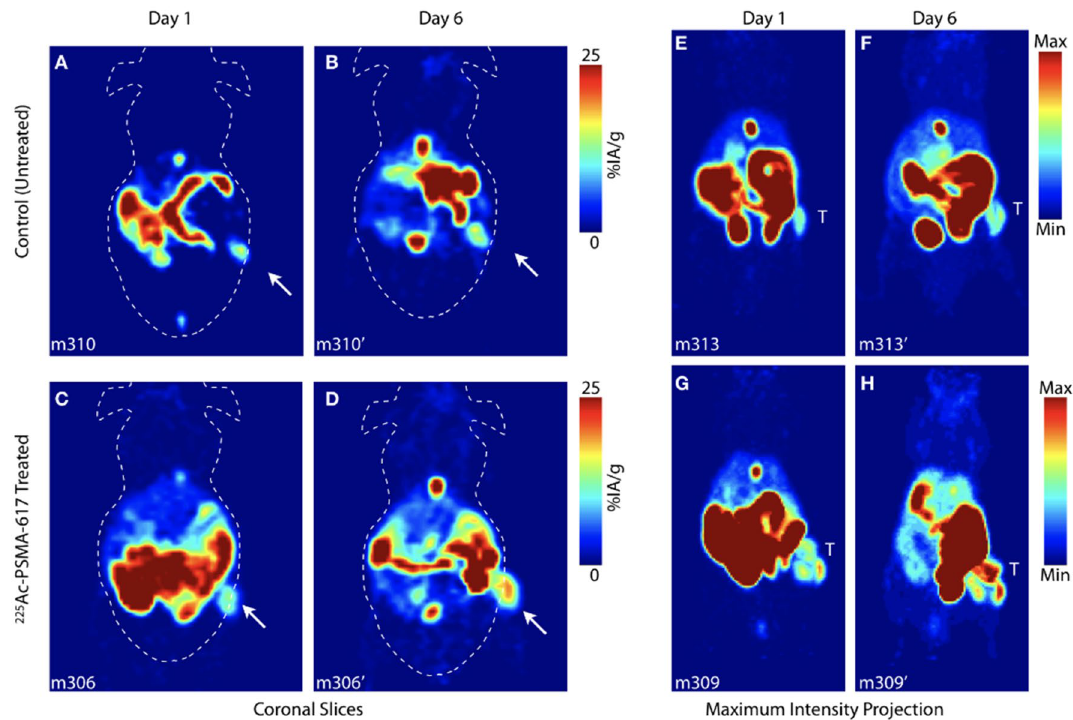
Figure 3. [ 18 F]-PARPZ PET Imaging of Control and Alpha Particle Irradiated Tumors. Coronal slice of representative control mouse bearing 22Rv1-Luc xenografts at ( A ) Day 1 and ( B ) Day 6. Whole-body coronal PET slice of [ 225 Ac]-PSMA-617 treated subject at ( C ) Day 1 and ( D ) Day 6. Distribution to the intestine (and gall bladder) recapitulates our previous work 27 ; and tumor is delineated as indicated (arrow). Representative Day 1 and Day 6 whole body maximum intensity projection (MIP) data for control (top) and treated (bottom) groups; tumor denoted